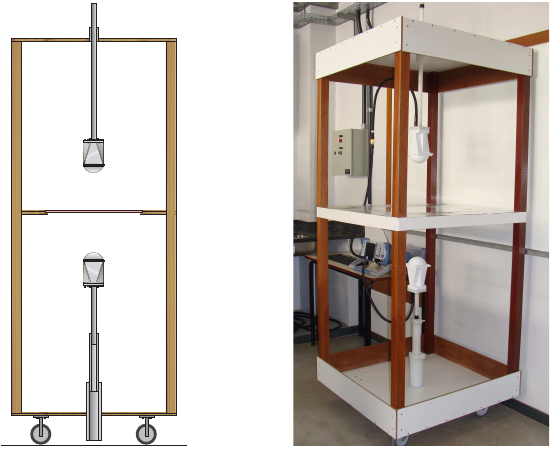
Figure 3. The sketch ( left ) and a photograph ( right ) of the experimental